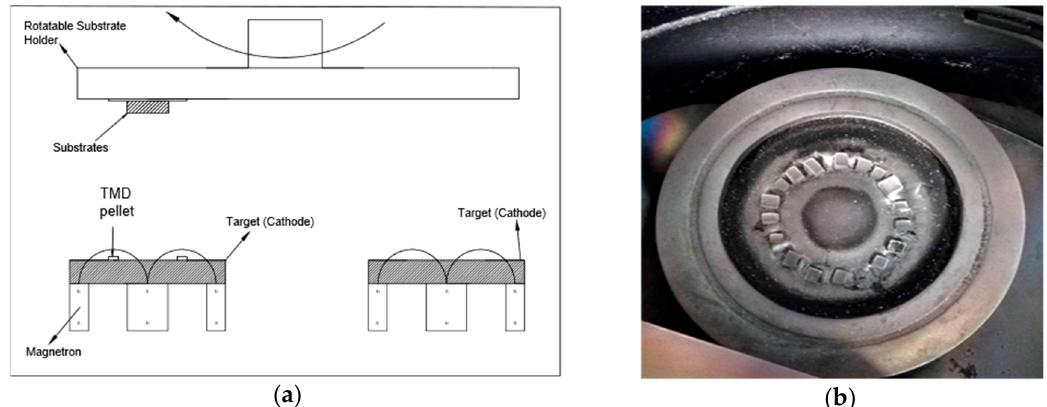
Figure 1. ( a ) Schematic of the RF magnetron sputtering unit; ( b ) carbon target with WS 2 pellets placed in the erosion zone.